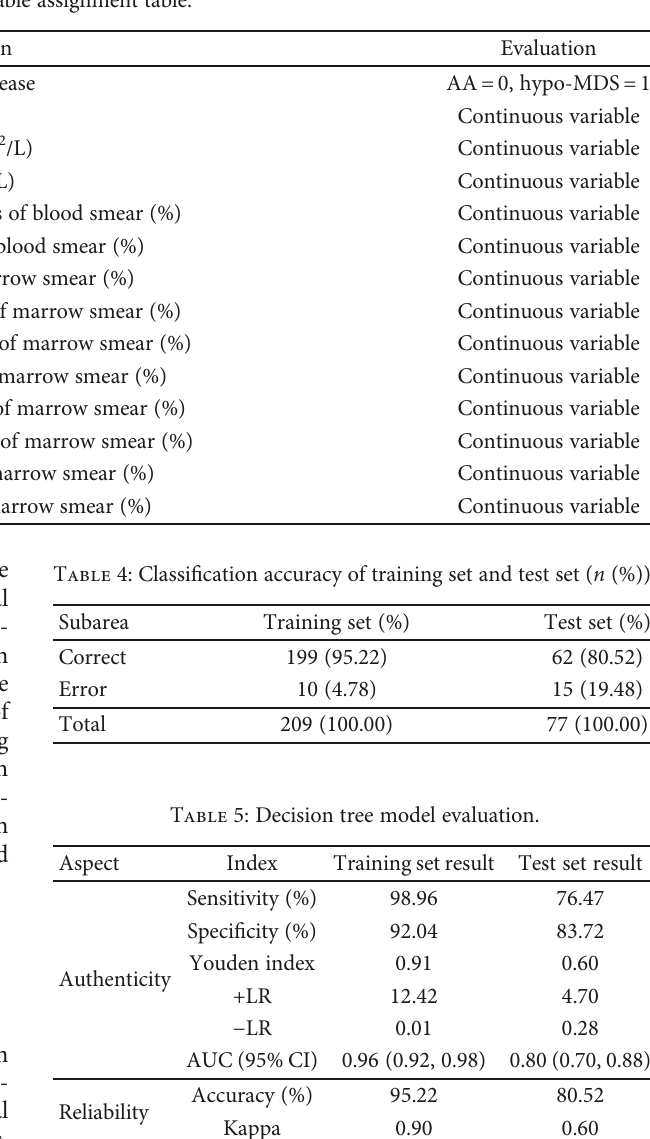
Table 3: Variable assignment table.